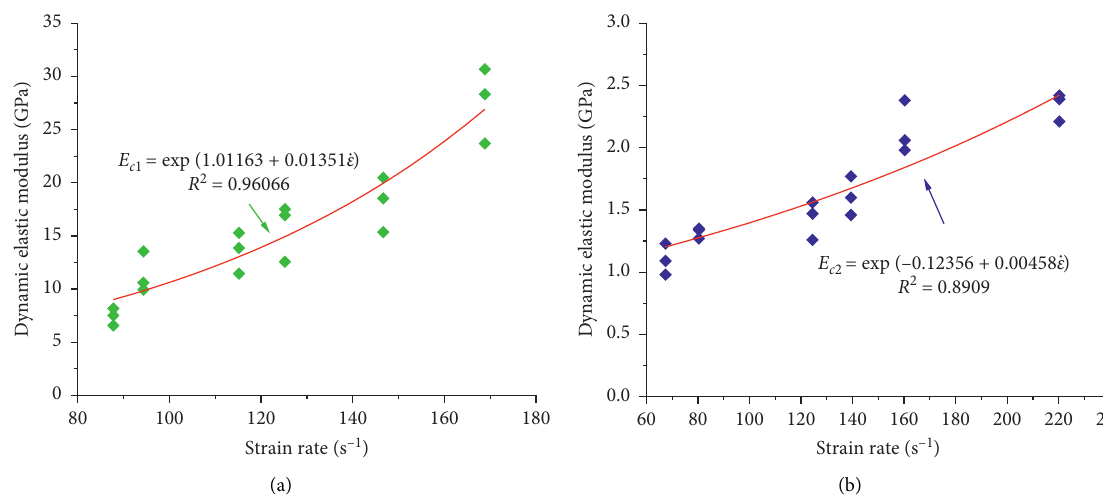
Figure 6: Relationship between dynamic elastic modulus and strain rate. (a) Rockburst-prone coal samples. (b) Nonprone coal samples.